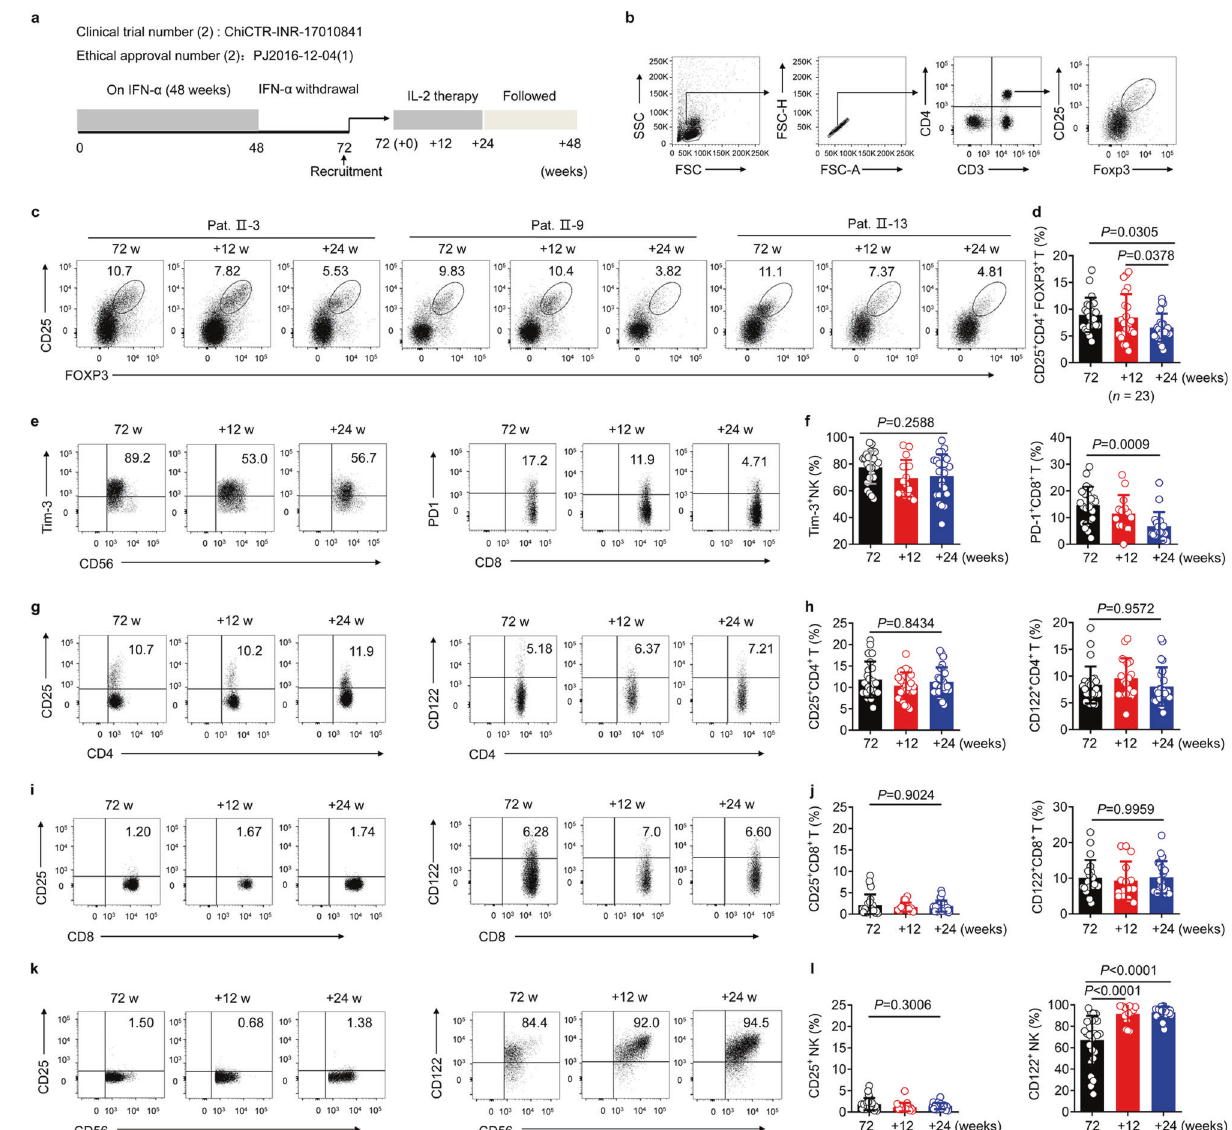
Fig. 3 Reduction in the expression of immunosuppressive molecules after IL-2 therapy in vivo. a Schematic representation of the study fl ow second clinical trial. b – l Data obtained from the PBMCs of NR ( α -2b) patients ( n = 23) were quanti fi ed at week 72 (72 w; 48 weeks of IFN- α -2b therapy and 24 weeks of follow-up) from the start of therapy, and after 12 ( + 12 w) and 24 weeks ( + 24 w) of sequential IL-2 therapy. b Gating strategy for Tregs within PBMC samples. c , d Representative density plots ( c ) and pooled data ( d ) showing the percentage of Tregs within the PBMCs during IL-2 therapy. Representative density plots ( e ) and quanti fi cation ( f ) showing sequential Tim-3 expression on NK cells ( e , f , left), and sequential PD-1 expression on CD8 + T cells ( e , f , right), during IL-2 therapy. FACS analysis of the sequential proportion of CD25 + CD4 + T cells ( g , h , left) and the proportion of CD122 + CD4 + T cells ( g , h , right) during IL-2 therapy. FACS analysis of the sequential proportion of CD25 + CD8 + T cells ( i , j , left) and the proportion of CD122 + CD8 + T cells ( i , j , right) after IL-2 therapy. FACS analysis of the sequential proportion of CD25 + NK cells ( k , l , left) and the proportion of CD122 + NK cells ( k , l , right) during IL-2 therapy. Data are analyzed by one-way ANOVA with Tukey ’ s multiple comparisons test ( d , f , h , j , l ); * P < 0.05; ** P < 0.01; *** P < 0.001; **** P < 0.0001. Data are presented as mean ± HBeAg levels were notably reduced in NR patients participating in the fi rst clinical trial at 72 weeks after the initiation of Peg-IFN- α -2b therapy, the decline in the 48-week follow-up after week 72 ( + 48 weeks; week 120) was not signi fi cant. The levels of HBeAb, AST, or ALT in these NR patients did not change signi fi cantly either, and HBV DNA was undetectable in the 48-week follow-up after week 72 (Supplementary Fig. 7a – d). Furthermore, we compared the HBeAg levels and immunological characteristics between the sequential IL-2 group and the no-sequential IL-2 group in the second trial. We found the serum HBeAg levels were much lower in the sequential IL-2 group than in the no-